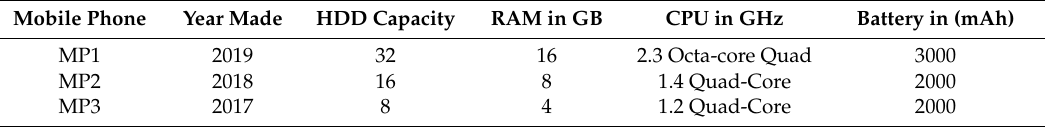
Table 1. Mobile phones used in the performance test of the app and their main relevant features. Mobile